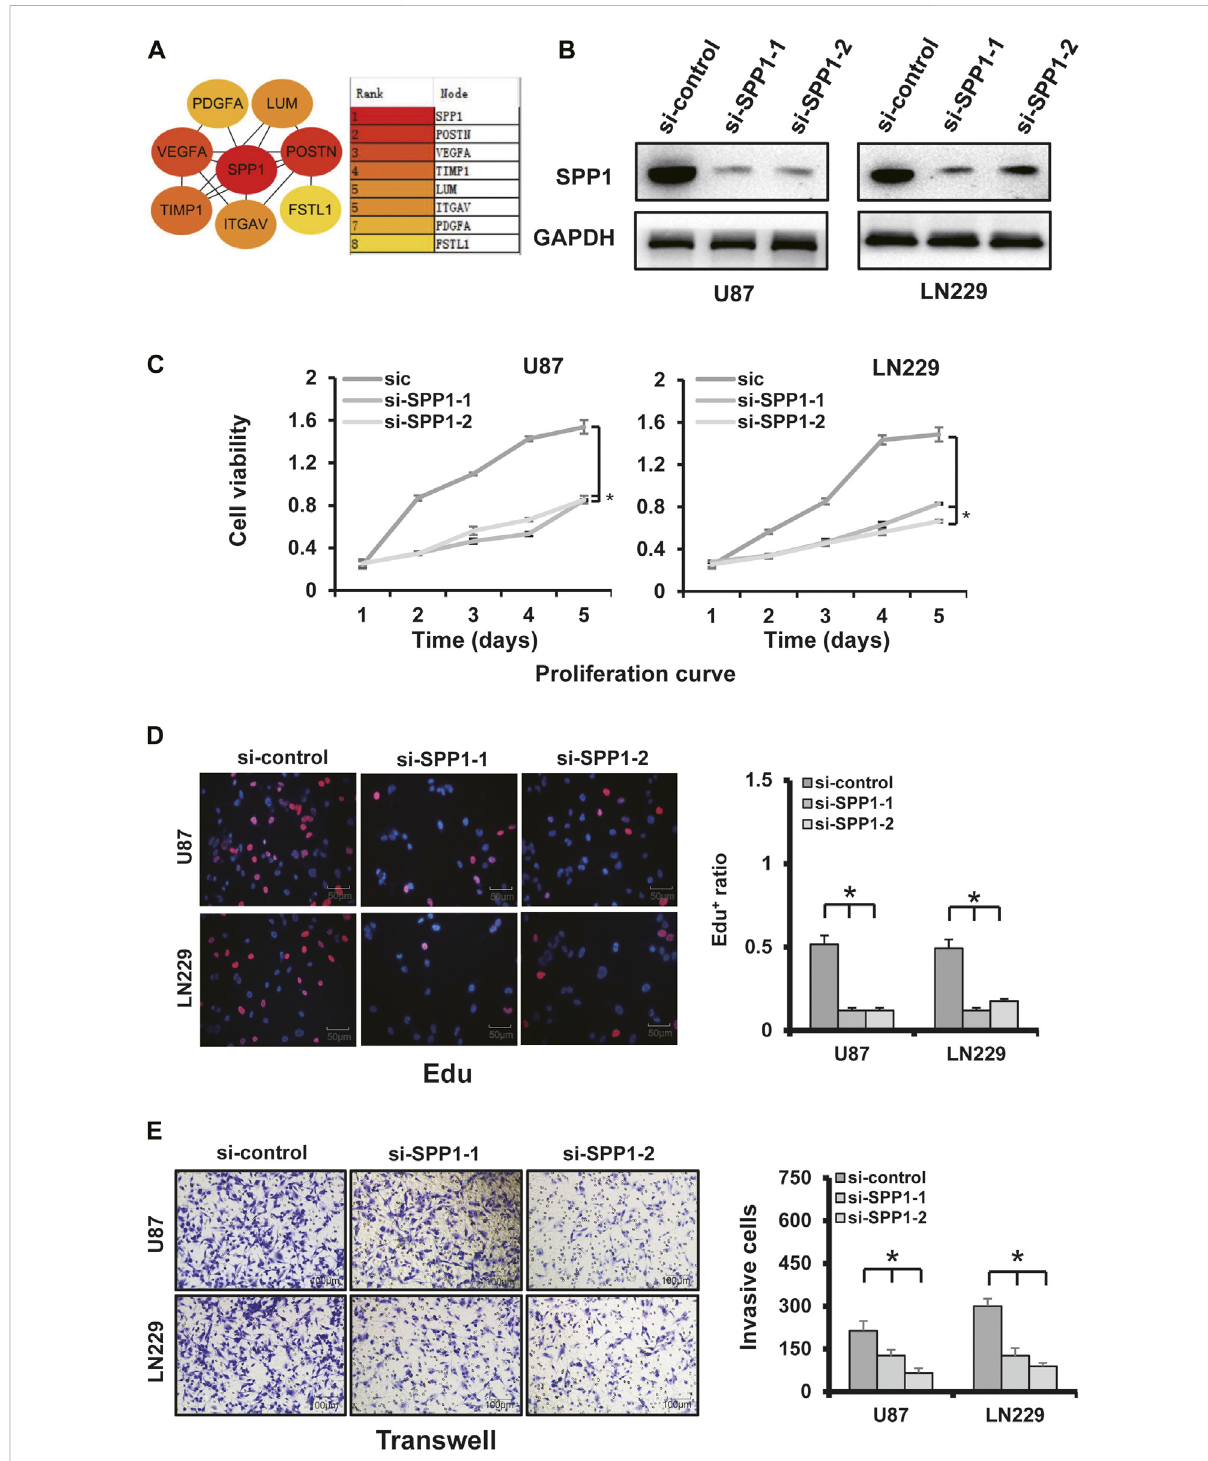
FIGURE 12 SPP1 experiments. (A) PPI analysisand theMCC method of cytoHubba showed that SPP1 had the highest hub node score. (B) SPP1 knockdown using two independent SPP1 siRNAs (si- SPP1 -1, si- SPP1 -2) in U87 and LN229 cells was evidenced by WB analysis. GAPDH was using as loading control. (C) Cellular-viability assays demonstrated that silencing SPP1 inhibited the growth of U87 and LN229 cells. (D) Representative images of cellular-proliferation assays using EdU staining (left) and quanti fi cation of EdU + cells (right). Nuclei were counterstained with Hoechst 33,342 (scale bar: 50 μ m). (E) Matrigel assay demonstrated that knockdown of SPP1 inhibited U87 and LN229 invasion (scale bar: 100 μ